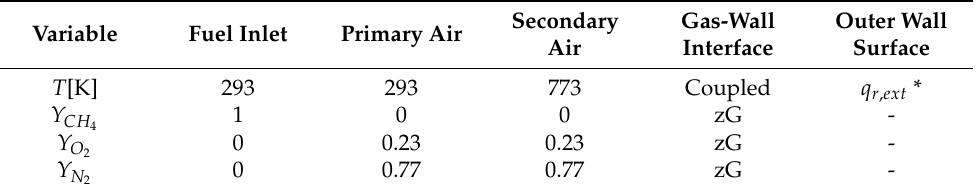
Secondary Gas-Wall Outer Wall Air Interface Surface